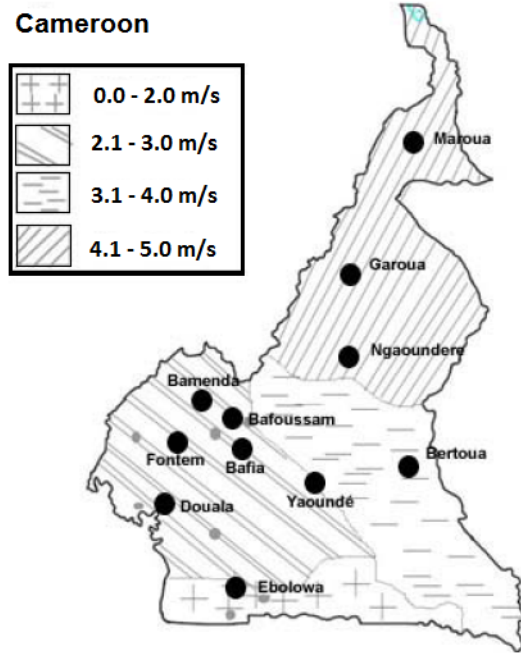
Figure 5. Map of Cameroon showing the mean monthly wind speed (10 m above height)